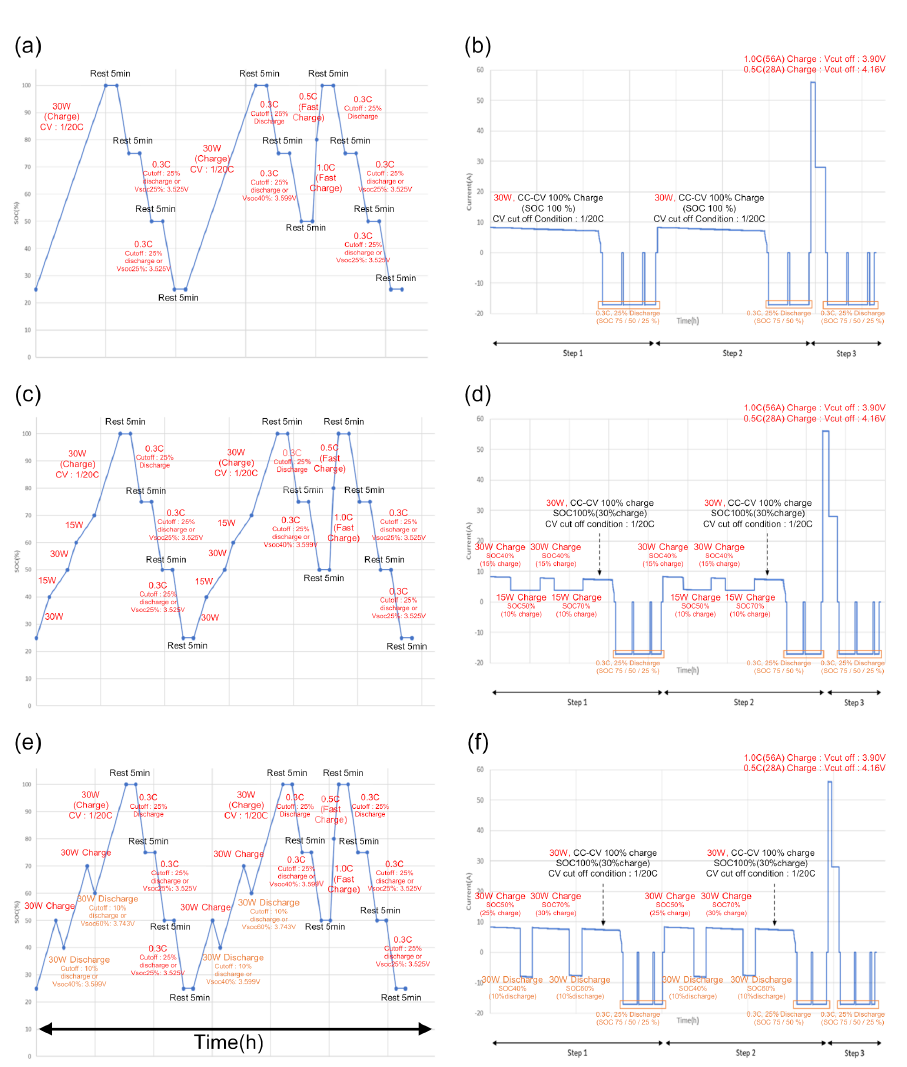
Figure 3. Changes in SOC and current according to pattern. ( a ) Changes in SOC for V0G pattern, ( b ) Changes in current for V0G pattern, ( c ) Changes in SOC for V1G pattern, ( d ) Changes in current for V1G pattern, ( e ) Changes in SOC for V2G pattern, ( f ) Changes in current for V2G